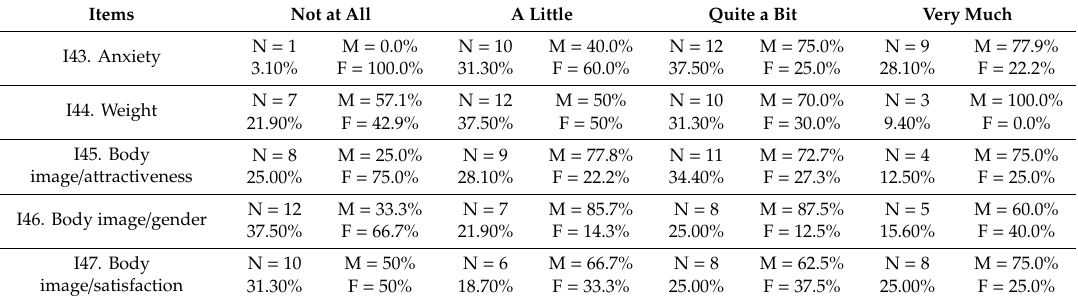
Table 4. Emotional functioning scale.